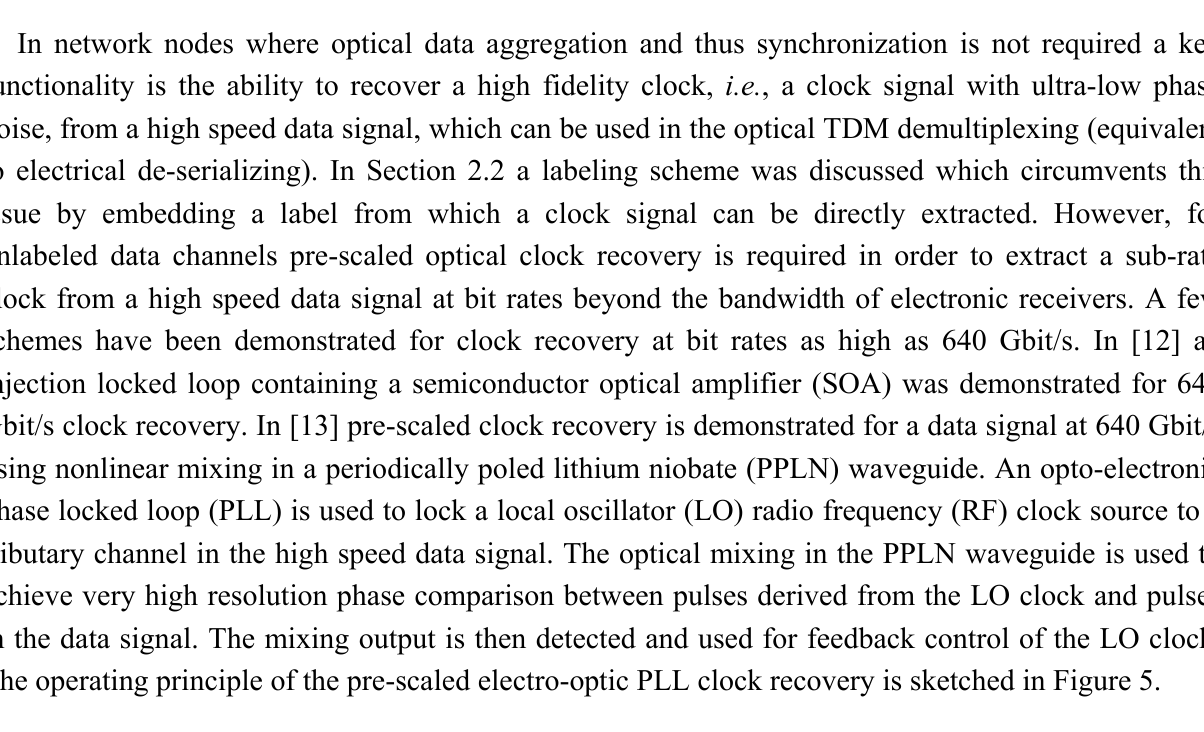
Figure 5. Working principle of pre-scaled electro-optic clock